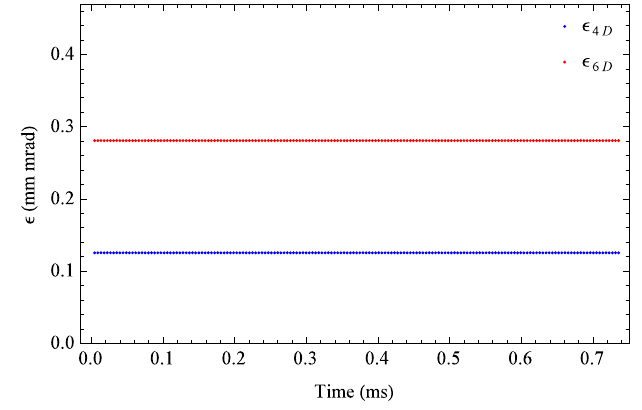
FIG. 14. A demonstration of symplecticity preservation by PHAD, showing the invariant RMS emittances ϵ 4 the C þ 6 ions beam in the absence of cooling. The emittances ϵ 4 and ϵ 6 are scaled as D